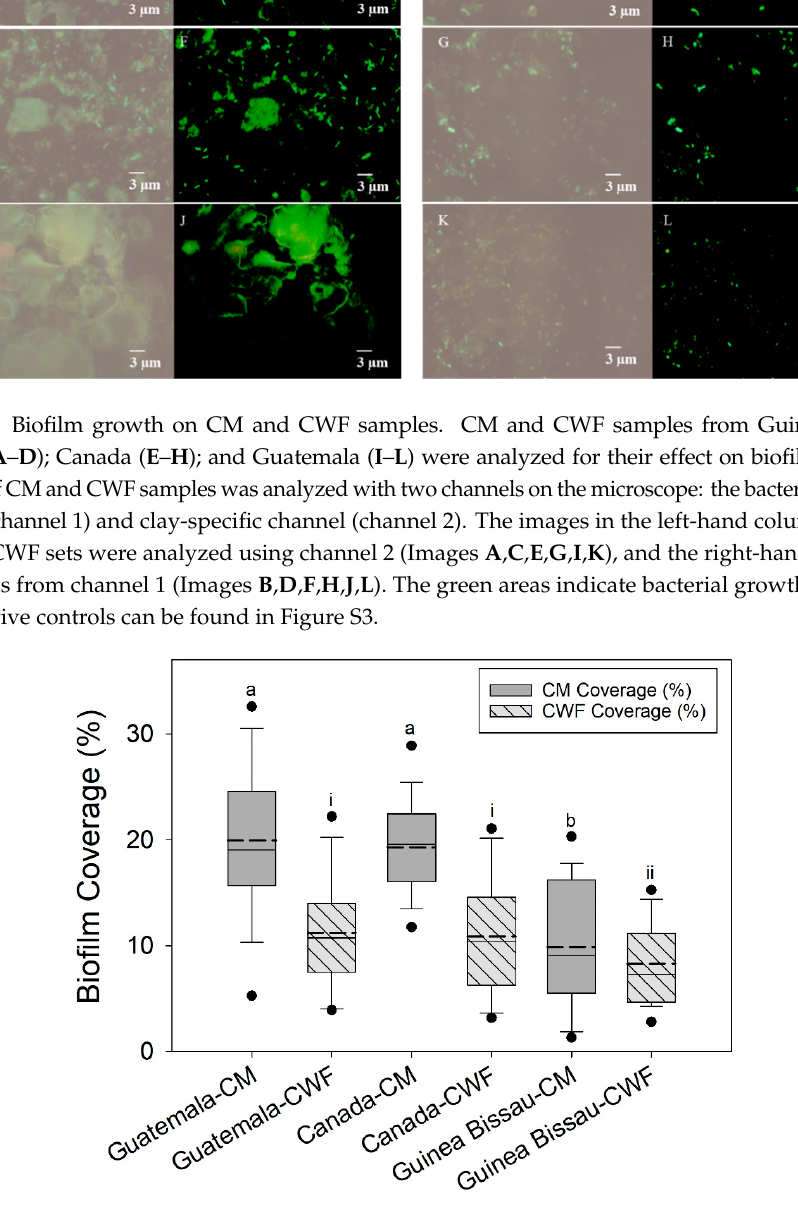
Figure 2. Biofilm coverage on CM ( solid bars ) and CWFs ( striped bars ). Average biofilm coverage was determined by analyzing each condition in triplicate at 10 or 11 different locations on each sample. See Table S3–5 for the full data set. In the box and whisker plots, the solid gray boxes are the CM samples and the striped boxes are the CWF samples. The tops and bottoms of the boxes are the 25th percentile with the mean ( dashed line ) and median ( solid line ) marked inside the boxes. The whiskers mark the 95th percentile and the dots mark the outliers. Letters ( a , b ) indicate statistical significance between CM samples, and Roman numerals ( i , ii ) indicate statistical significance